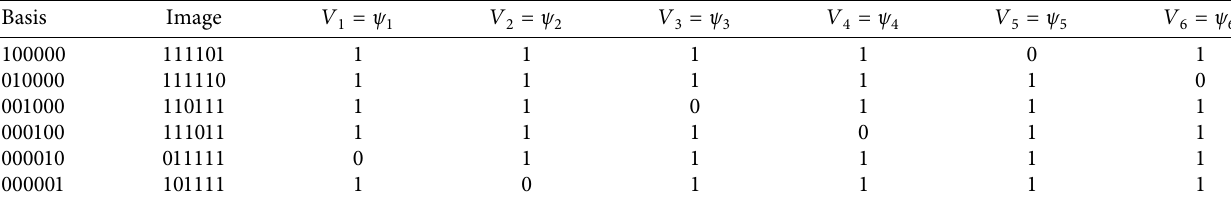
Figure 6: Modified Schubert. Table 1: Mappings of basis elements to the Modified Schubert.